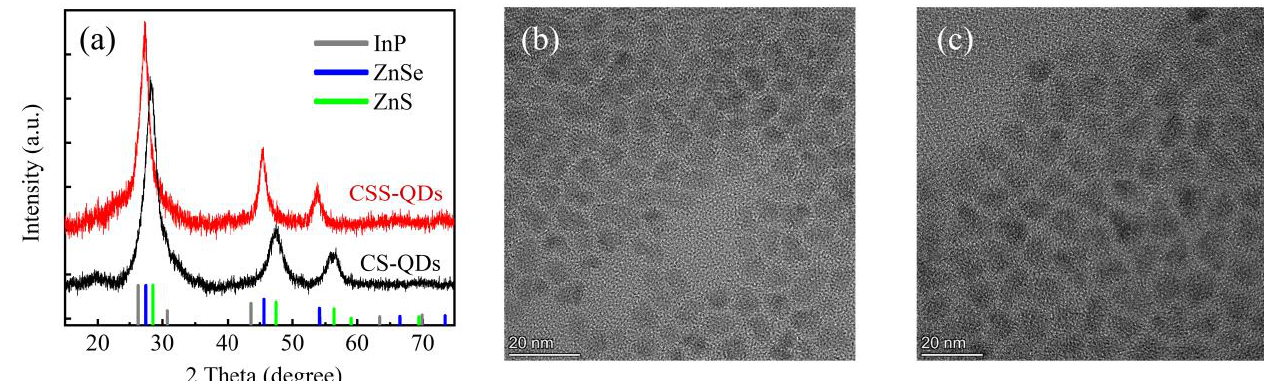
Figure 1. ( a ) XRD patterns for the CS-QDs and CSS-QDs. The vertical lines below indicate the diffraction peak positions of zinc-blended InP (gray), ZnS (green) and ZnSe (blue). ( b , c ) TEM images of both CS-QDs and CSS-QDs, respectively.